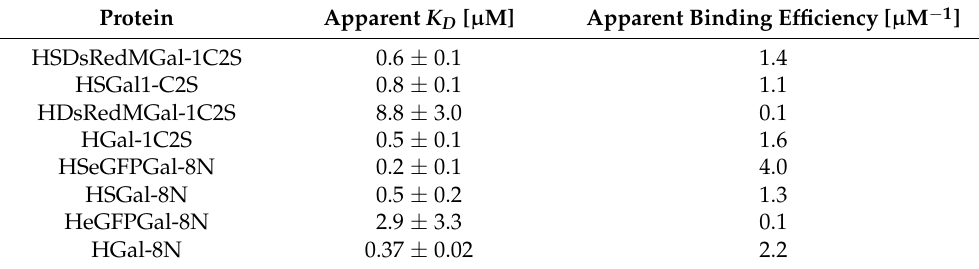
Figure 5. Binding of Gal-1C2S ( A ) and Gal-8N ( B ) fusion proteins after IMAC Figure 3. Comparison of Gal-3 binding on ASF depending on the purification mode. The chromatography. Binding of IMAC-purified proteins HSDsRedMGal-1C2S and Binding of IMAC-purified proteins HSDsRedMGal-1C2S and HSeGFPGal8N ( (cid:4) ), HSGal-1C2S and binding of HGal-3 ( (cid:4496)(cid:4497) ) and HSYGal-3 ( ⬛ ) is shown for IMAC-purified ( A ) and HSeGFPGal8N ( ⬛ ), HSGal-1C2S and HSGal-8N ( (cid:4496)(cid:4497) ), HDsRedMGal-1C2S and HSGal-8N ( IMAC/ASF-resin-purified ( B ) galectins. Galectin binding was detected with a peroxidase-conjugated anti-His 6 -antibody and conversion of TMB as the mean signal of three data points. Errors indicate standard deviations. Table 3. Apparent K D values and binding efficiencies of IMAC-purified Gal-1C2S and Gal-8N His 6 - tagged and fusion proteins in a solid-phase assay on ASF. Values were calculated by non-linear regression assuming one-site